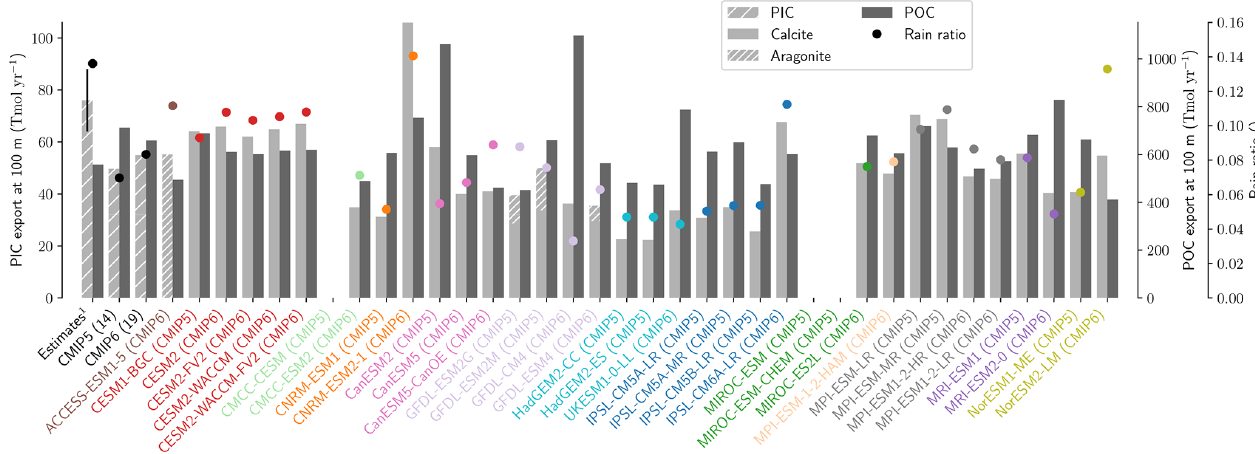
Figure 6. Export of PIC and POC at 100m. The globally integrated PIC and POC export at 100m (bars) and the corresponding rain ratio (points). The respective contribution of calcite and aragonite to PIC export is shown for individual ESMs. Observationally derived estimates of PIC and POC export are respectively from Sulpis et al. (2021; 1 assessment at 300m) and DeVries and Weber (2017).